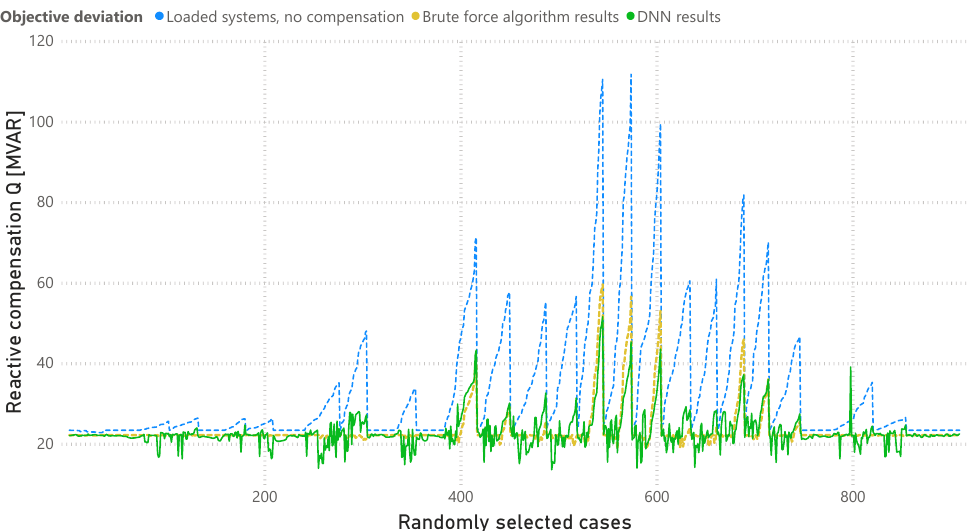
Figure 8. Objective deviations for 909 scenarios: original system, loaded system, brute force results and DNN results.